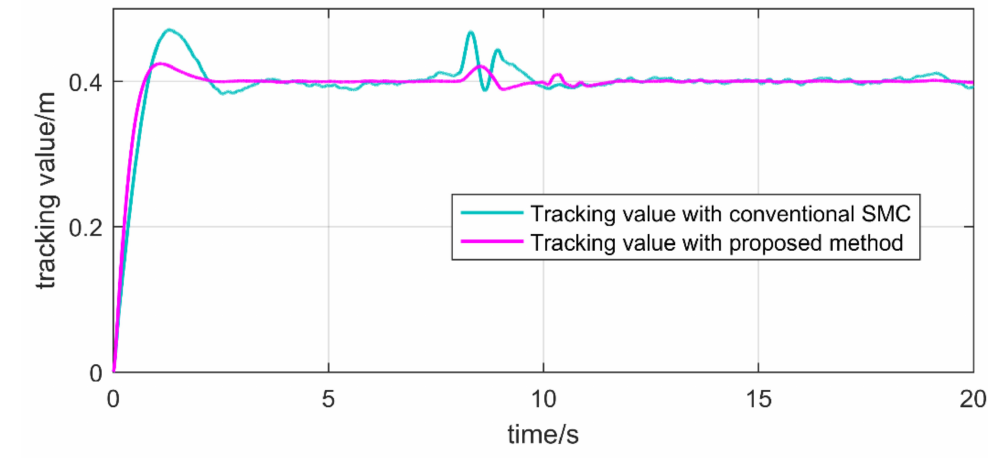
Figure 4. Trajectory tracking of position x .